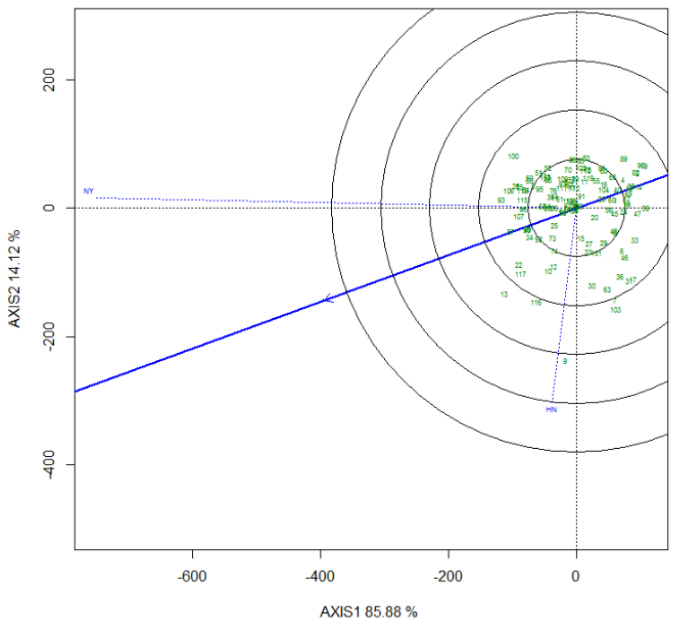
Figure 2. Discrimination and representativeness of H. The average environment axis is the blue solid line through the origin, and the dotted line is the environment vector of the two sites. The test area discrimination was measured based on the environment vector length. Site discrimination improves with longer dotted lines. The test site is represented by the angle between the dotted and the solid blue lines. The representativeness increases as the angle decreases. The angle between the two dotted lines—the site angles—can indicate a correlation [6]. Same as in Figure 5.